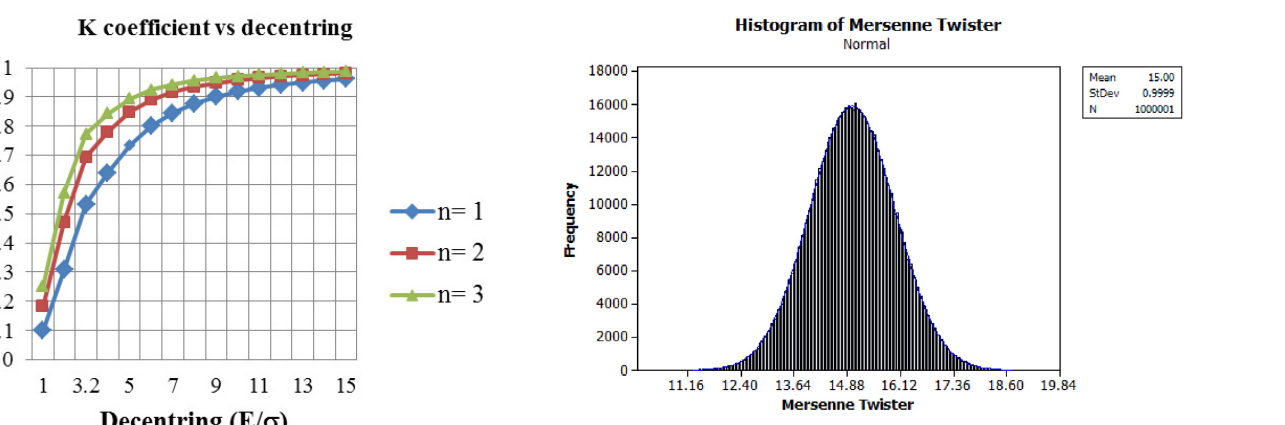
Fig. 4. Histogram of the data provided by the Mersenne Twister.